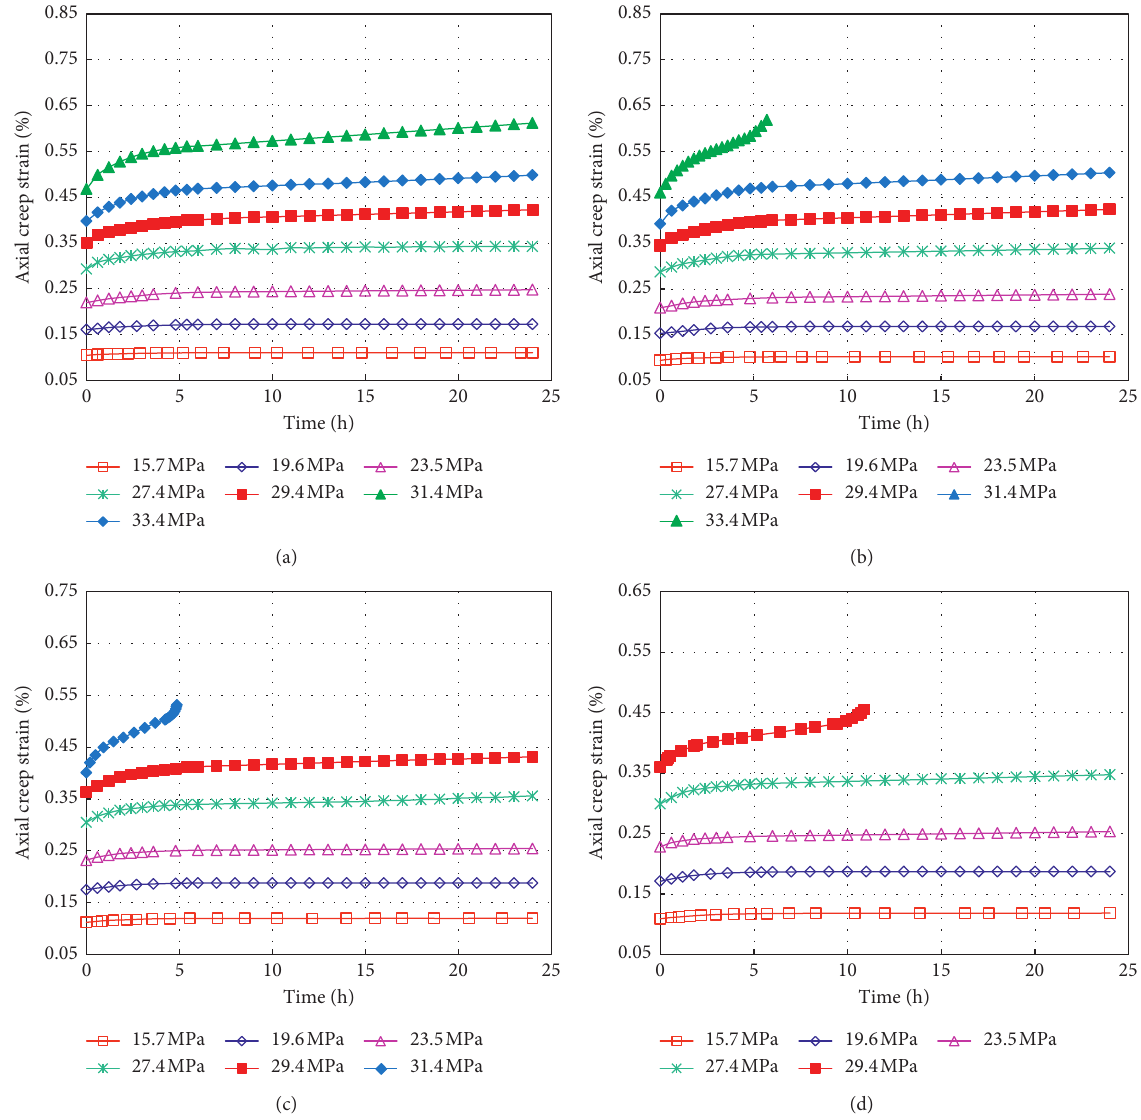
Figure 6: Creep curves of rock specimens with different initial damage: (a–d) the rock specimens with initial damage state D D 4 ,